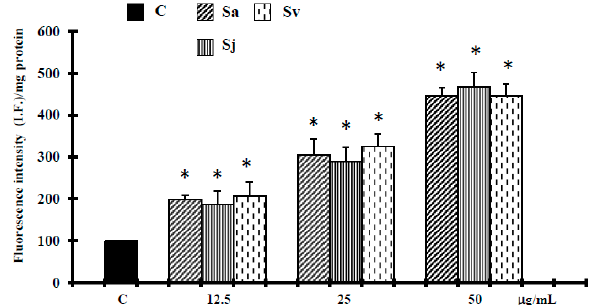
Figure 6. Reactive oxygen species (ROS) determination, performed by using a fluorescent probe 2 ′ ,7 ′ -dichlorofluorescein diacetate (DCFH-DA), in DU-145 cells untreated and treated with different concentrations of the essential oils from Sa, Sj and Sv for 72 h. The values are the mean ± standard deviation (SD) of three experiments performed in quadruplicate. *Significant vs. control untreated cells ( p < 0.001).